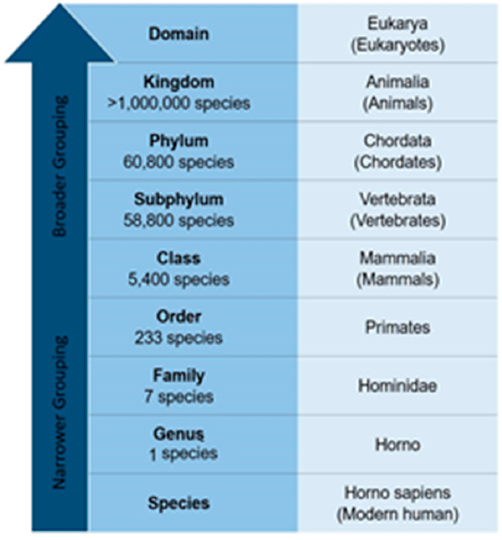
Figure 1. Taxonomy Hierarchy of Modern Human.